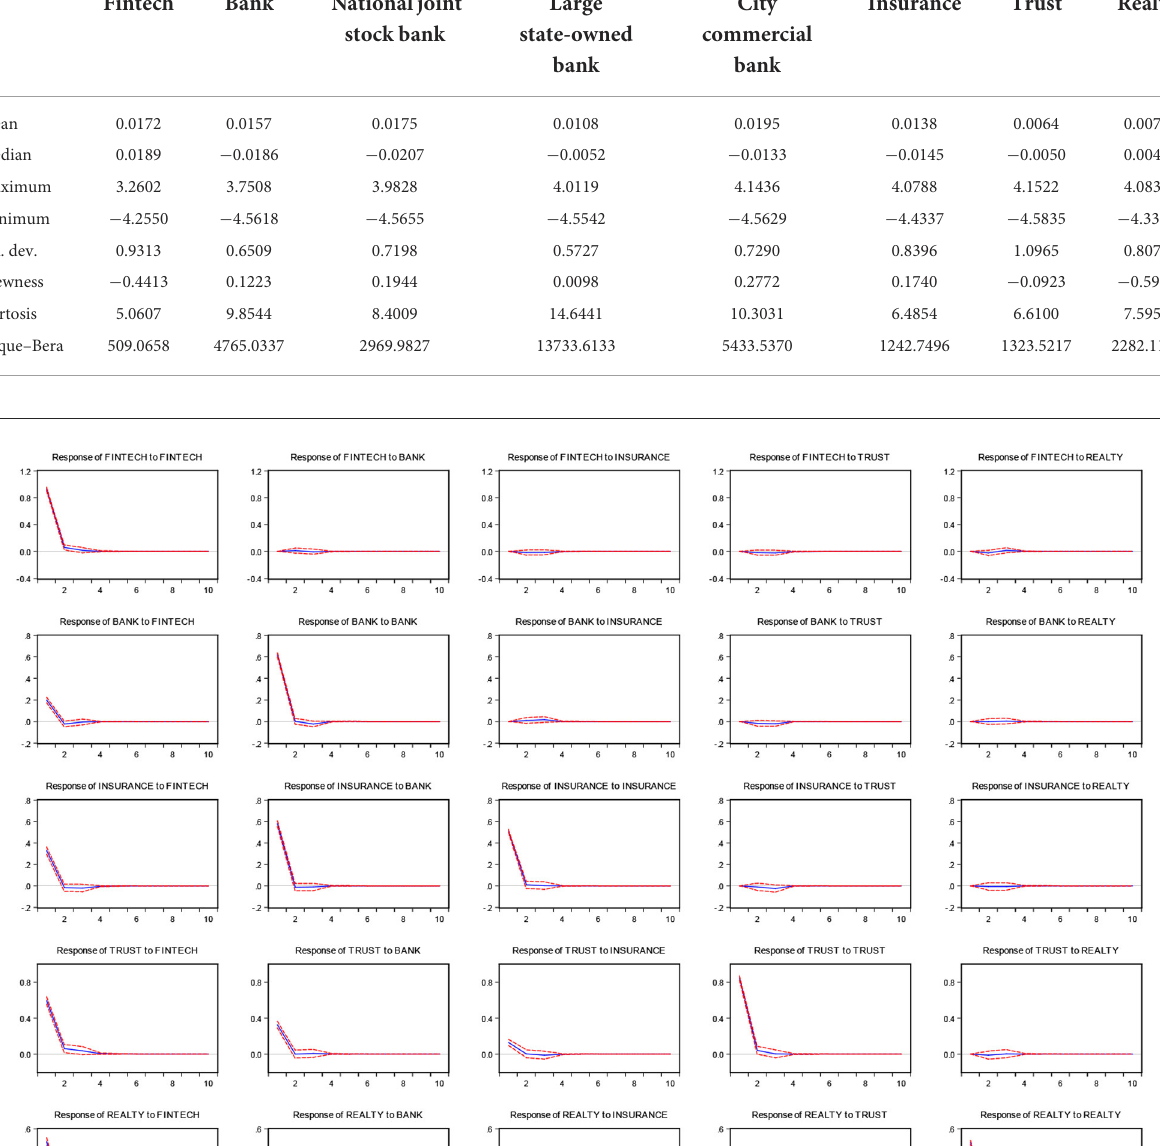
accurately captures the correlation between time series, and effectively evaluates the long-term change of correlation. The main advantages of the DCC-GARCH model are the positive definiteness of the conditional covariance matrices and the model’s ability to estimate time-varying volatilities, covariances, and correlations among the assets in a parsimonious